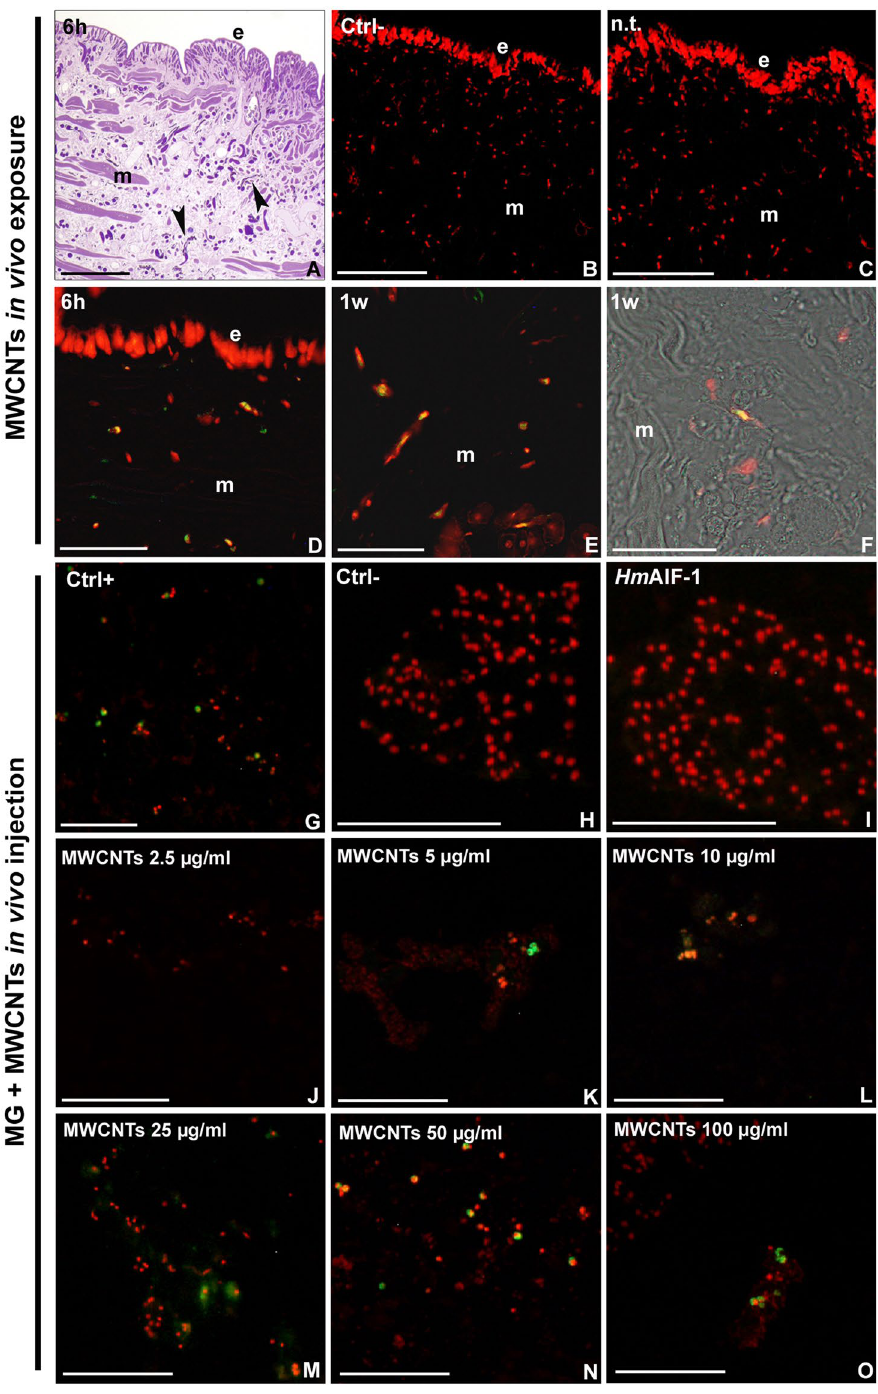
Figure 4. TUNEL assay for apoptotic nuclei detection in leech body wall ( A – F ) and in MG sections ( G – O ). Optical images showing numerous macrophages (arrowheads) migrating in the leech body wall after MWCNT treatment ( A ). Negative control ( B ). N.t. ( C ) and MWCNT treated leeches ( C – E ). Combined optical and fluorescence images of leech body wall showing TUNEL + cells migrating among muscle fibers ( F ) (e: epithelium; m: muscles). Positive ( G ) and negative controls ( H ) on MG samples. MG supplemented with Hm AIF-1 ( I ) and with Hm AIF-1 and increasing concentration of MWCNTs ( J – O ). Nuclei, counterstained with propidium iodide result in red while TUNEL positivity in green. The merge results in yellow. Bars in ( A – C , G – O ) 100 µ m; Bars in ( D–F ) 50 µ